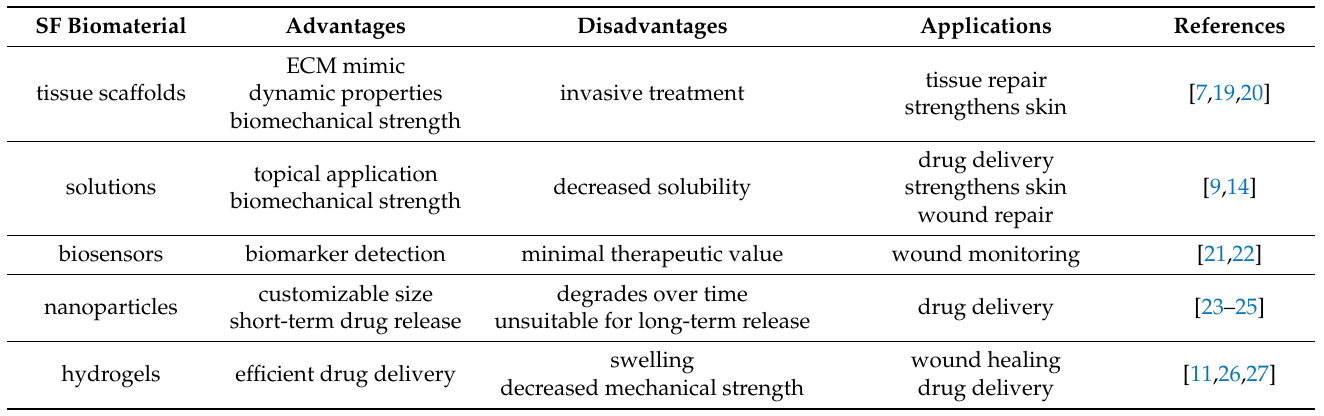
Table 1. Advantages and disadvantages of